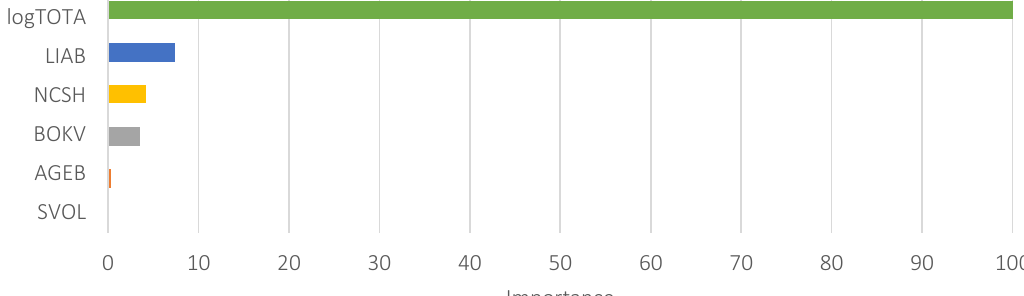
Figure 2. Linear regression variable importance scores for EPS